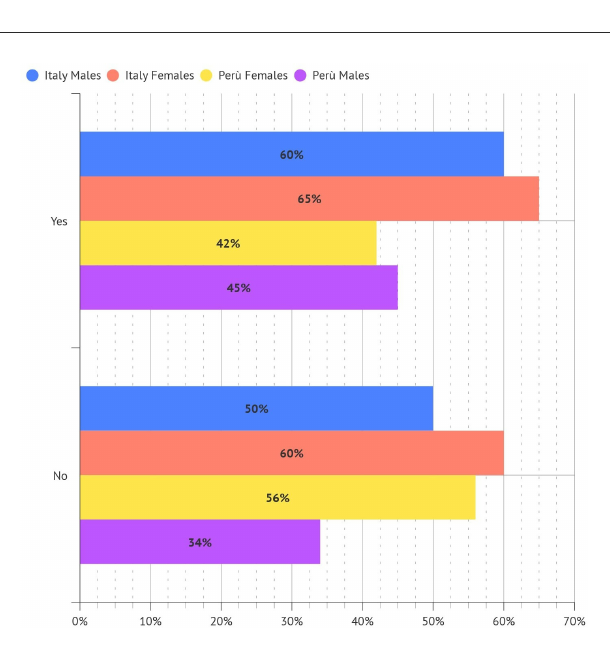
FIGURE4 Percentage of dentistry professionals engaging in physical